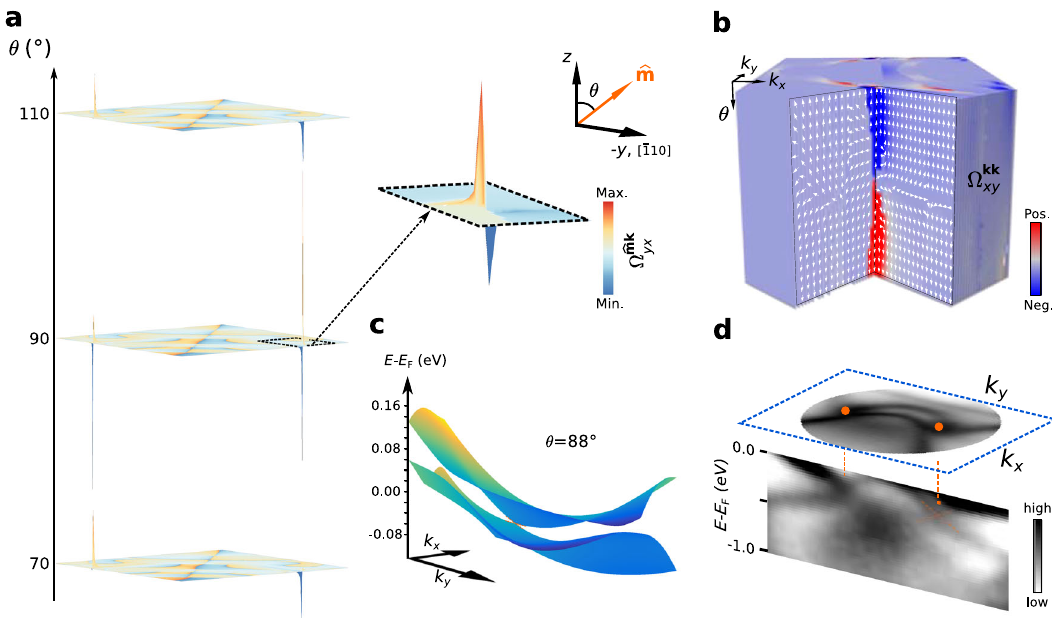
Fig. 5 | Mixed Weyl cones in a 2D topological ferromagnet. a The mixed Berry (negative,Neg.)tored(positive,Pos.)encodesthemomentumBerrycurvature Ω kk xy b mk θ ); inset in the composite space of k and θ . c Calculated band dispersionof the mixed Weyl curvature distribution Ω yx as a function of the magnetization direction ( shows a magni fi ed view near one end of the surface arc to highlight the sharp cone emerging at θ =88°. Colour shading indicates the binding energy ranging change in its sign across the projected mixed Weyl nodes. A logarithmic colour from − 0.08eVto0.16eV. d Measuredbanddispersionsalongastraightcutthrough scaleandalinearheight fi eldareused,wherered(blue)denotespositive(negative) two intersection points indicated by orange dots. Surface Fermi arcs spanning in values. b Monopole-like fi eldofthephase-spacedistributionoftheBerrycurvature the k x – k y planeconnecttheprojectionofthemixed Weylnodes. The experimental Ω = ð(cid:3) Ω b mk Ω b mk Ω kk Þ near the end points of the Fermi arcs at θ =88°. Arrows indi- observation of band crossings near the Fermi level agrees well with theoretical yy , yx , xy predictions in c . The orange dashed lines are a guide to the cate the direction of the Berry curvature fi eld, and the colour scale from blue